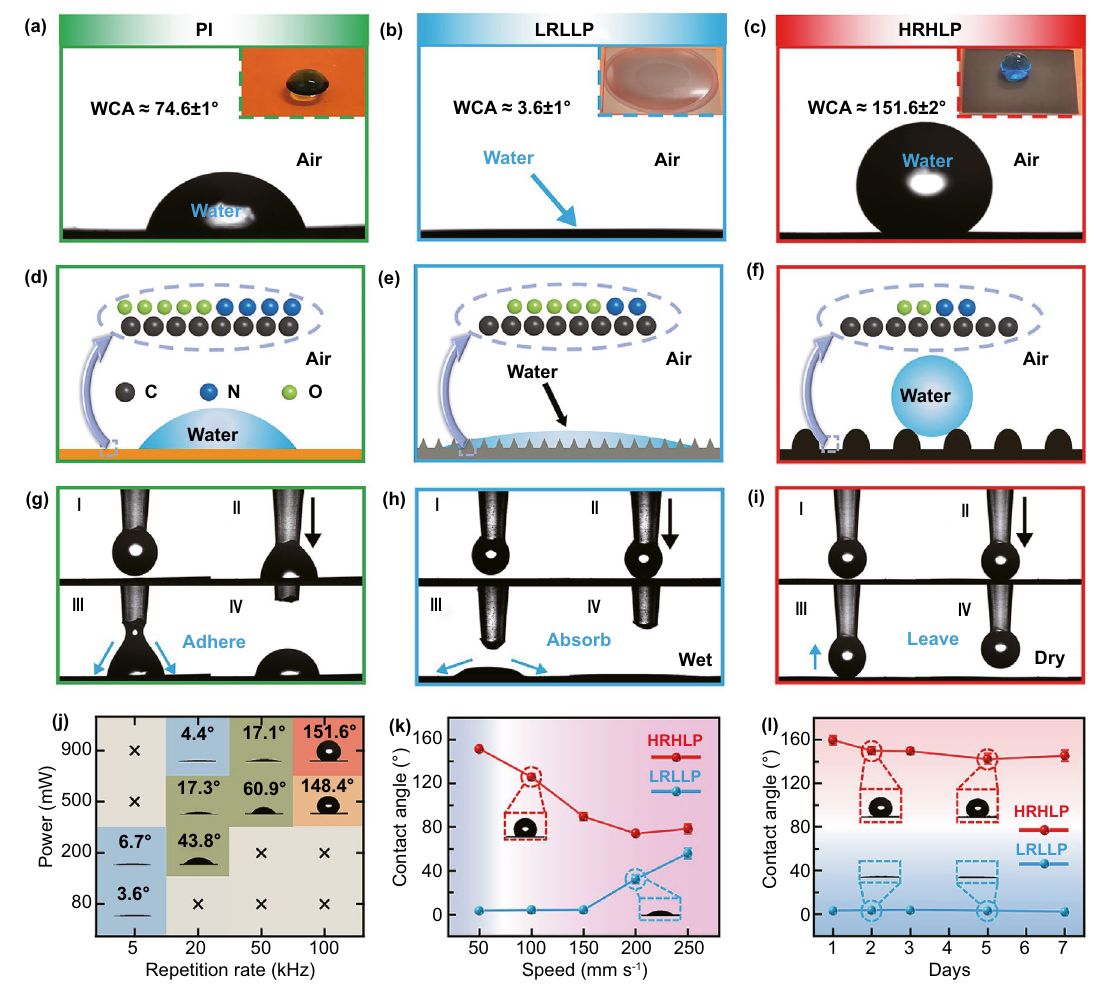
Fig. 3 Static WCAs of a PI, b LRLLP, and c HRHLP films. Mechanism illustration of d PI, e LRLLP, and f HRHLP film surfaces wettability. Dynamic wetting behaviors of a water droplet (4 μL) on g PI, h LRLLP, and i HRHLP film surfaces. j Static WCA of the laser-treated PI film at different laser repetition rate and power. “ × ” means that the laser power cannot reach the designative value or is less than the damage threshold under the corresponding repetition rate. k WCAs of the LRLLP and HRHLP films with different laser scanning speeds. l WCAs of the LRLLP and HRHLP films placed in air for 7